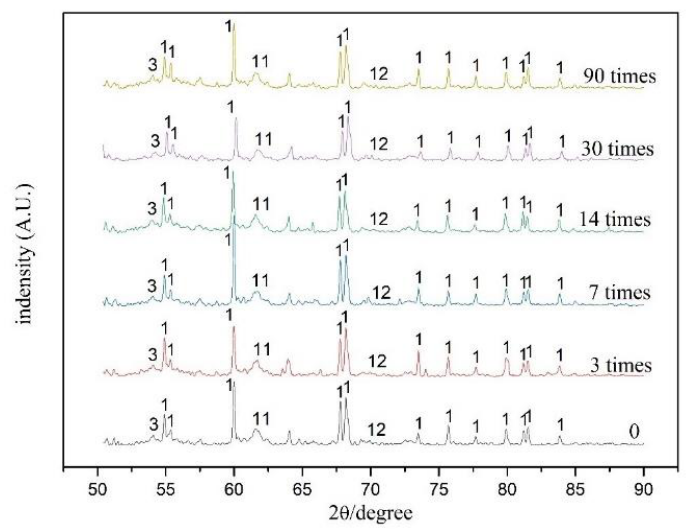
Figure 12. 1‚SiO 2 , 2—Anorthite, 3—CSH, 4—CaZnSiO 4 , 5—Pb(OH) 2 , 6—CAH, 7—Cd(OH) 2 , Figure 1 2 1‚SiO 2 , 2—Anorthite, 3—CSH, 4—CaZnSiO 4 , 5—Pb(OH) 2 , 6—CAH, 7—Cd(OH) 2 , 8— 8—Clinohedrite, 9—Erionite, 10—Gismondine, 11—Zn(OH) 2 , 12‚Ca(OH) 2 Clinohedrite, 9—Erionite, 10—Gismondine, 11—Zn(OH) 2 , 12‚Ca(OH) 2 .